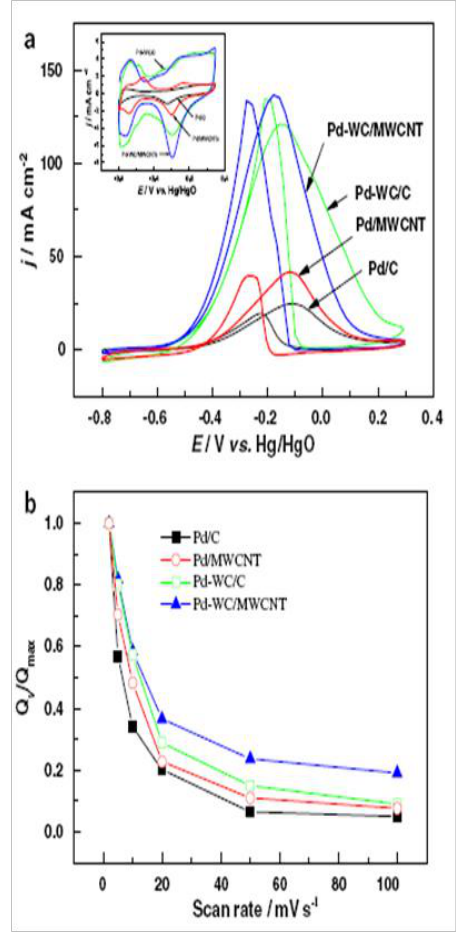
Figure 10. (A) TEM images of (a) WC/MWCNT, (b, c) Pd-WC/MWCNT and (B) the half cell results of various electrocatalysts for ethanol oxidation (Reprinted from Reference 96 with